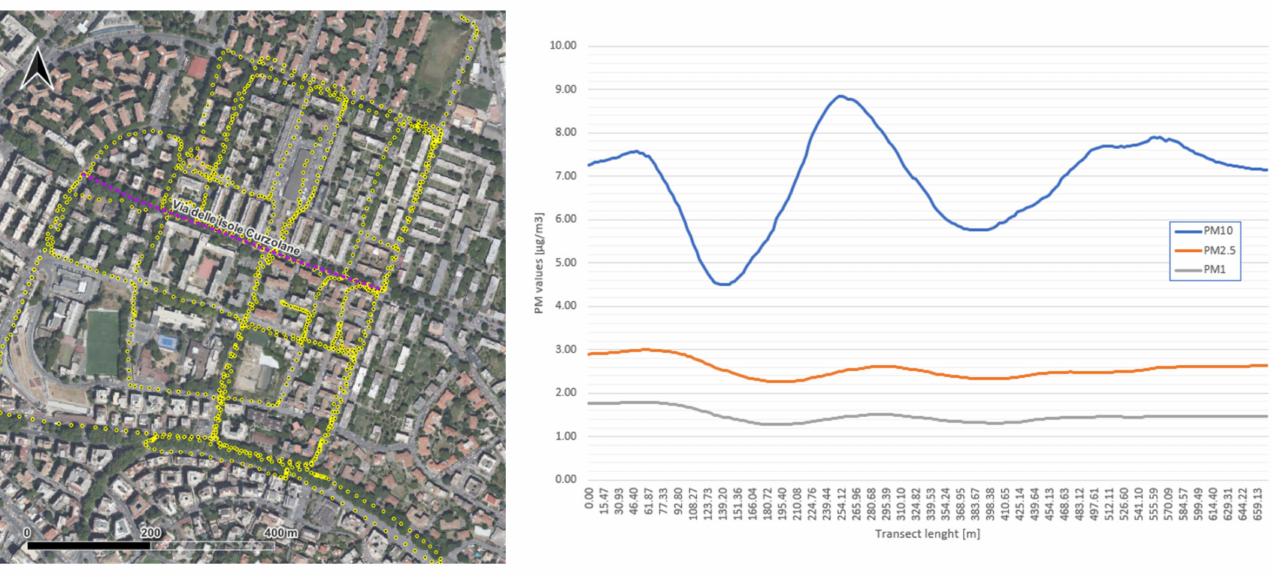
Figure 9. PM-1 (gray), PM-2.5 (orange), and PM-10 (blue) trends along transect 2 (Via delle isole Curzolane, depicted in violet on the map. PM acquisitions are depicted in yellow). For the sake of comparison, the available official ARPA data from the local fixed monitoring station report an average value over the entire day of 18 µ g/m 3 for the PM-10 content only. The here-reported data, besides also analysing the PM-1 and PM-2.5 content, are relative to a time window of 10 min around 11:00 AM and for the PM-10 content give an average value of about 12 µ g/m 3 near the ARPA